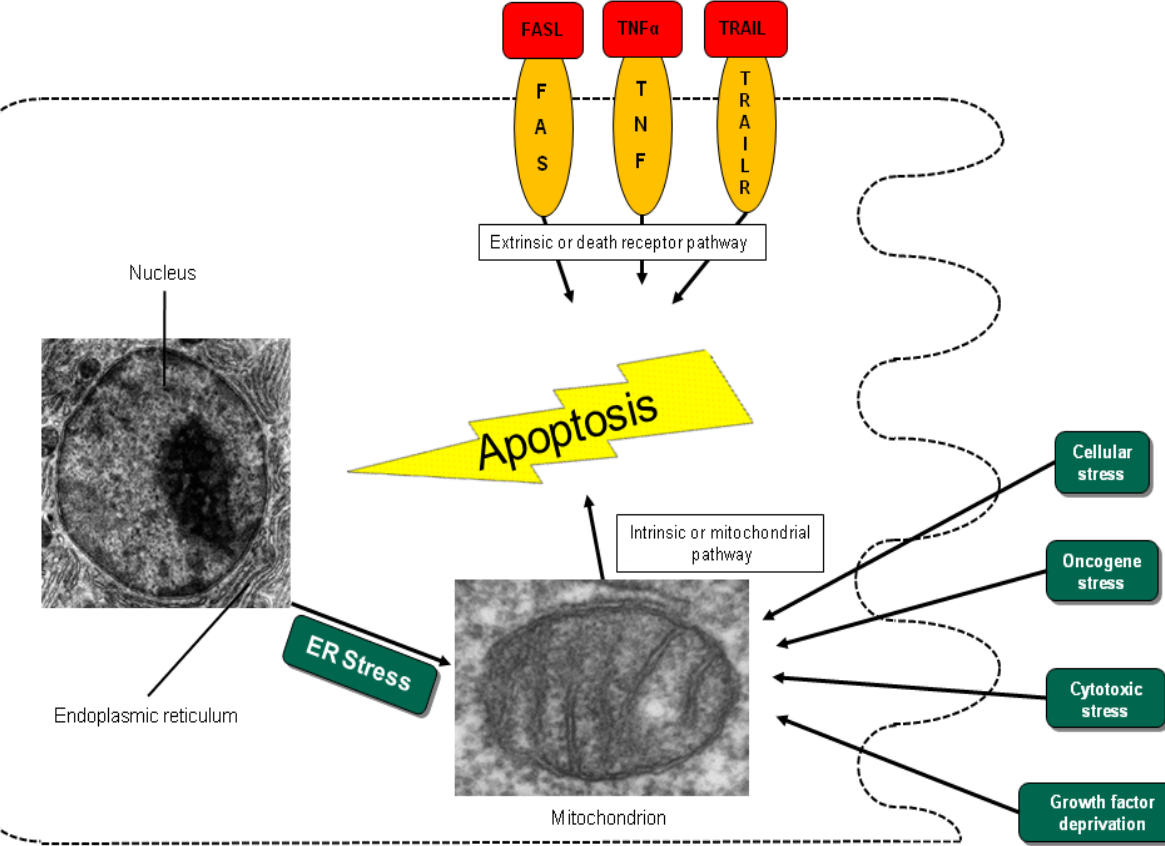
Figure 1. Different entry points to apoptosis. The extrinsic or death receptor pathway is triggered by the interaction of the receptors Fas, TNF and TRAIL and their natural